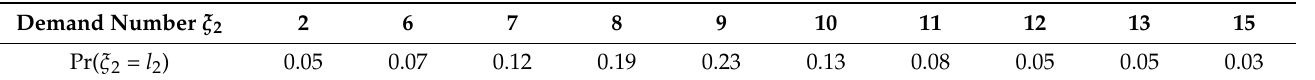
Table 6. Stage-2 demand probability forecast in a month.